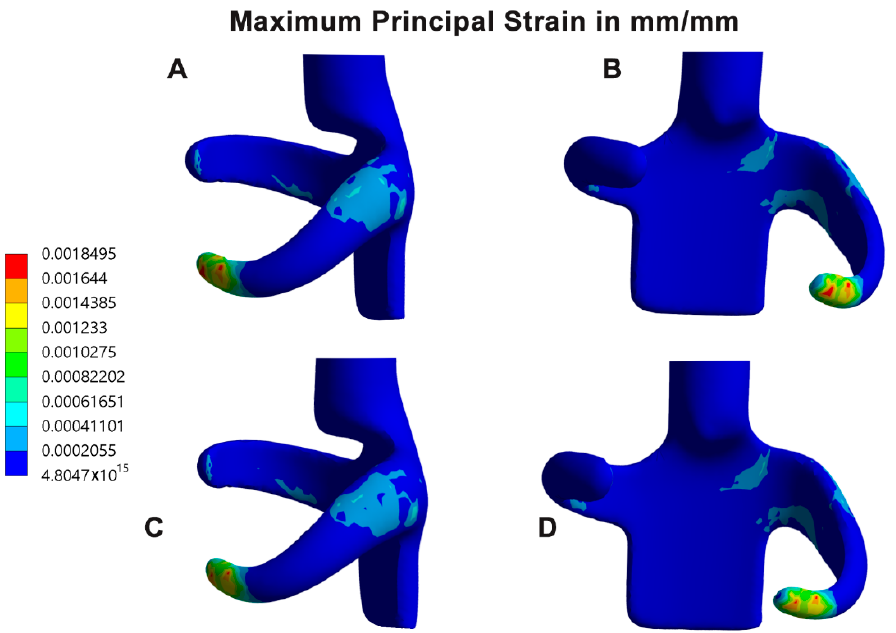
Figure 5. ( A , B ) Scaled color map of the maximum principal strain (in mm/mm) of the PEEK clasp showing areas of higher stress from buccal and mesial views, respectively. ( C , D ) Corresponding views of the GBP clasp.